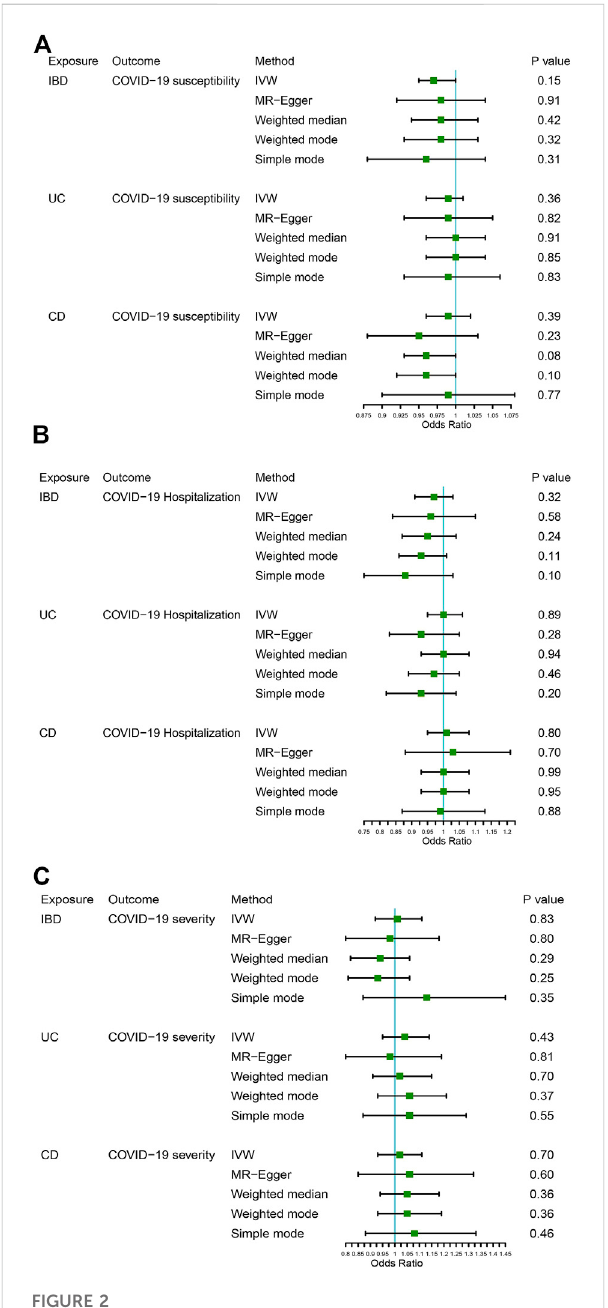
FIGURE 2 TheassociationbetweenIBD(including UCandCD)andCOVID- 19 susceptibility, hospitalization, and severity. (A) COVID-19 susceptibility, (B) COVID-19 hospitalization, (C) COVID-19